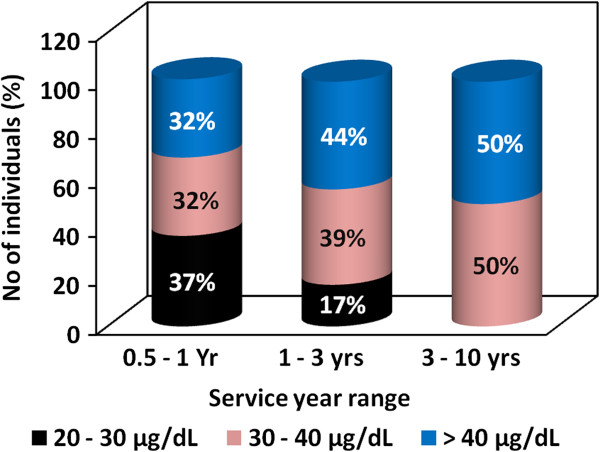
Proportion of individuals with BLLs between 20–30 μg/dL, 30–40 μg/dL and above 40 μg/dL among the construction workers with service years between 0.5 – 1 year, 1 – 3 years and 3 – 10 years.